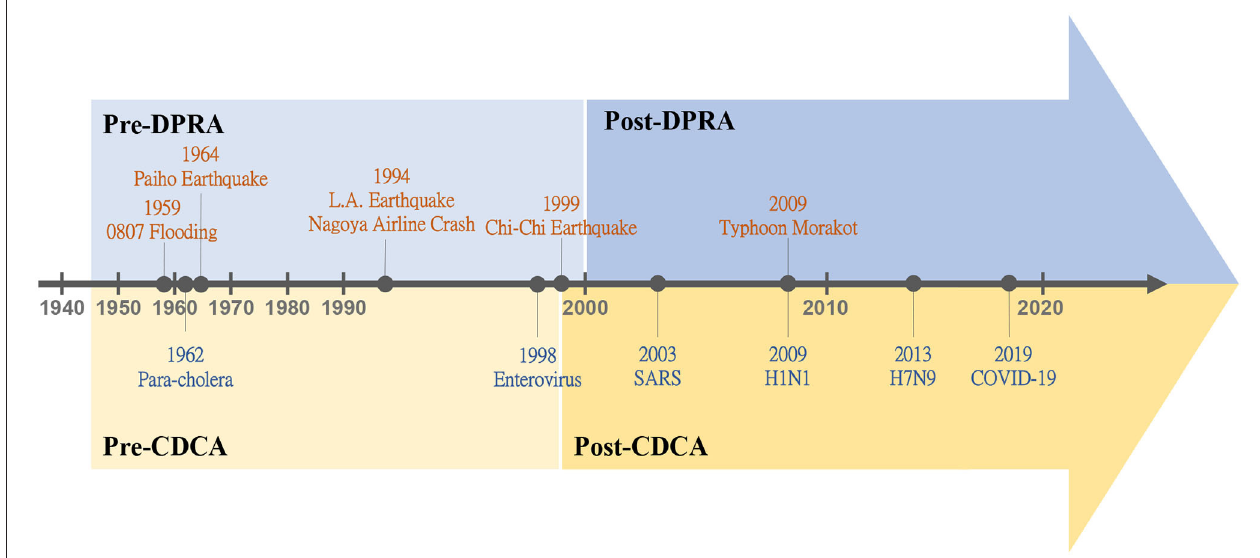
FIGURE 3 | The evolutions of disaster management systems for natural disasters and communicable diseases in Taiwan (where DPRA represents Disaster Prevention and Response Act; CDCA represents Communicable Disease Control Act).